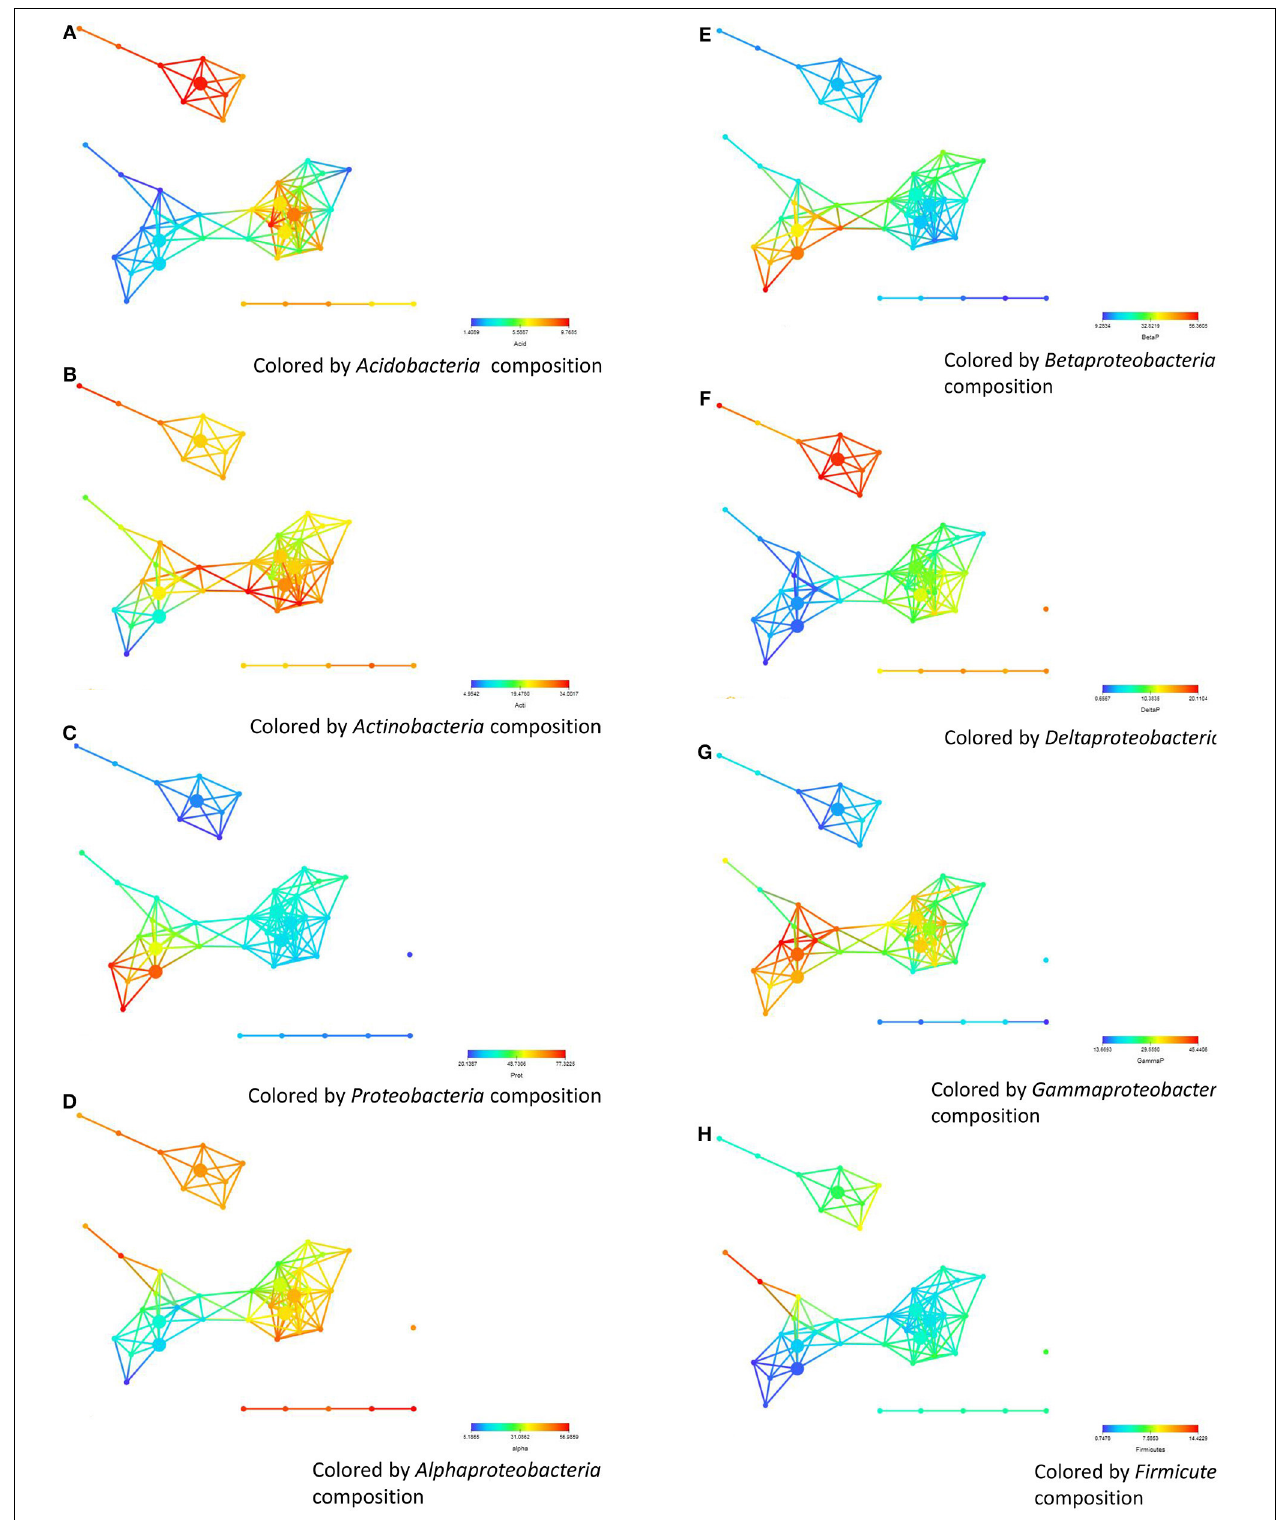
FIGURE 5 | The abundance and distribution of different bacterial phyla based on pyrosequencing and their correlation with survival. (A) soils from Salinas Valley region, sub-networks (B,C) Yuma and the Imperial region. (A–H) represent the coloring of the